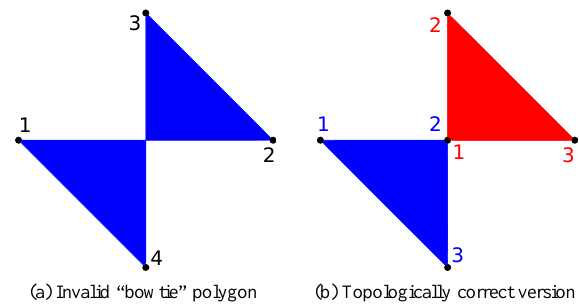
Figure 1: Invalid geometry before and after correction with ST